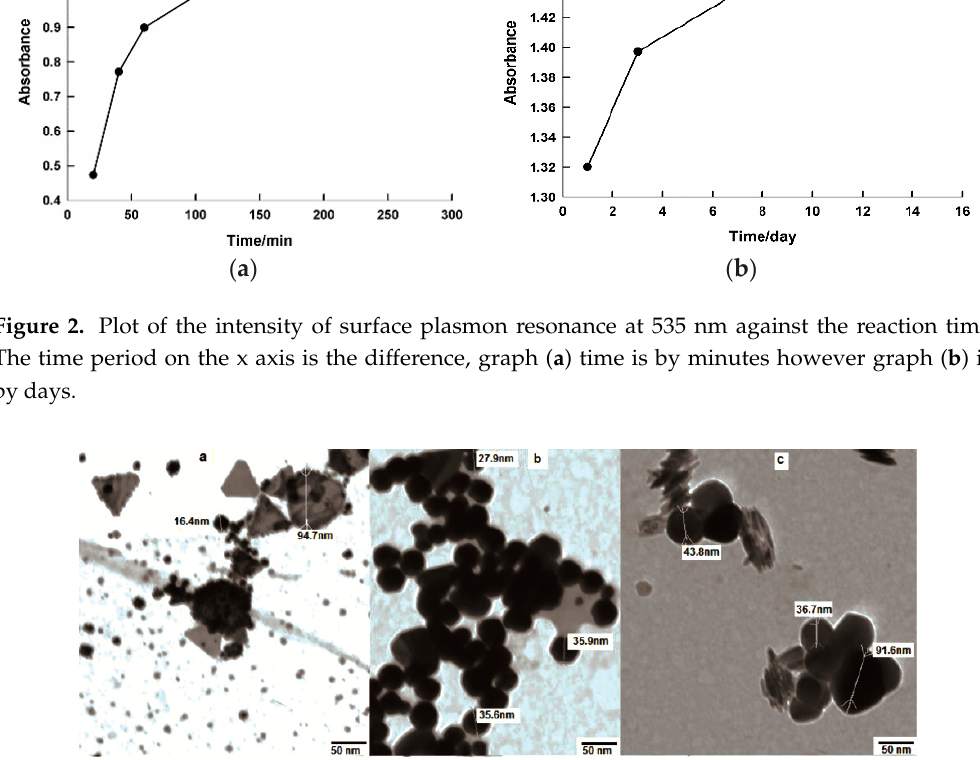
Figure 2. Plot of the intensity of surface plasmon resonance at 535 nm against the reaction time. The time period on the x axis is the difference, graph ( a ) time is by minutes however graph ( b ) is by days.